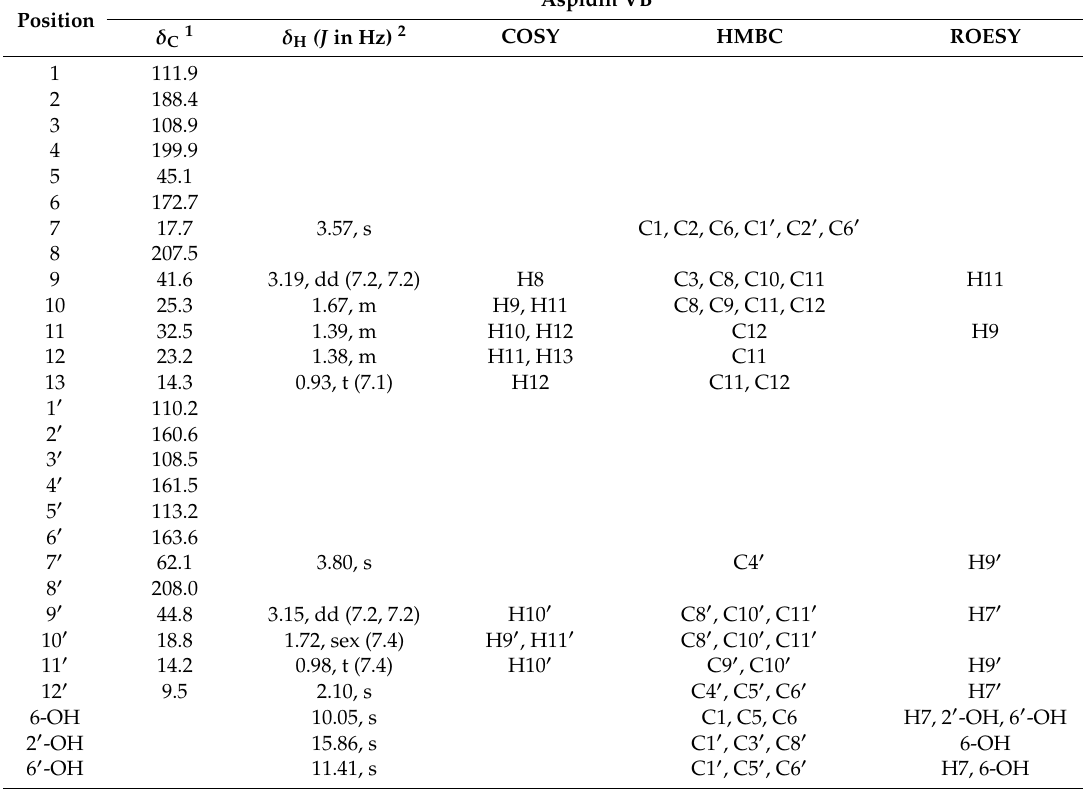
Table 1. The 1D and 2D NMR data for Aspidin VB ( 2 ) in acetone- d 6 .